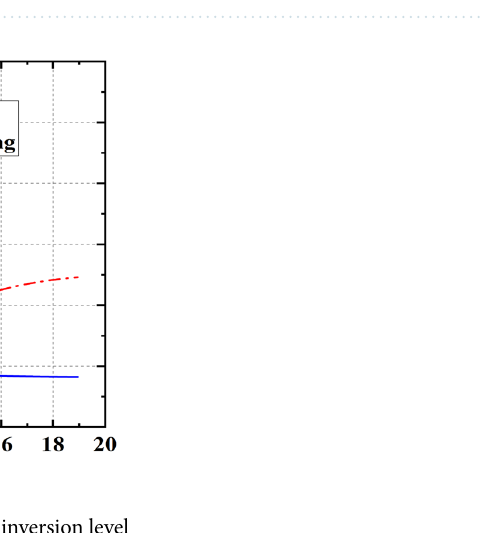
Figure 3. ( a ) Output and backward light powers at different pump powers in the Hybrid pumping configuration. ( b ) Comparison of the co and hybrid pumping inversion level